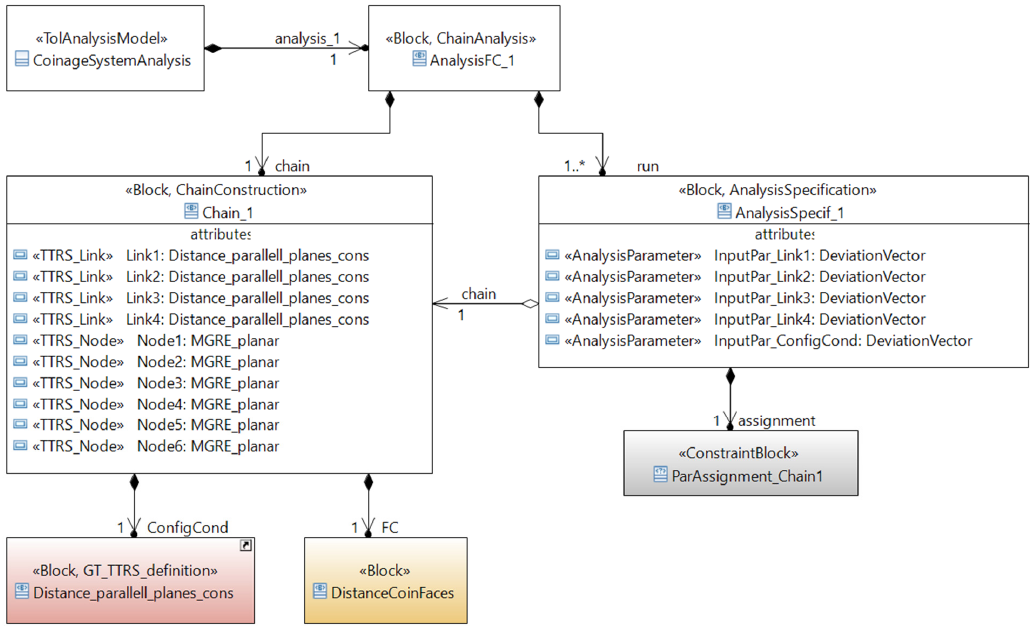
Figure 21. BDD of the general tolerance analysis model structure (“1..*” is a “one to many” multiplicity).